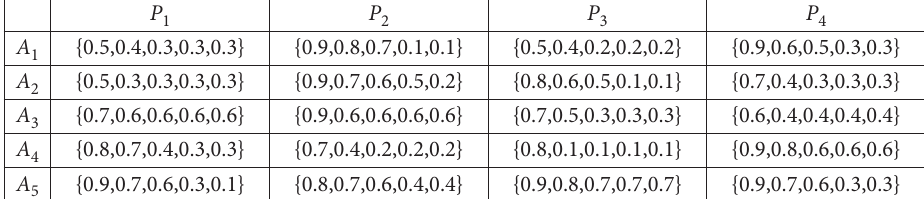
Table 2. Hesitant fuzzy decision matrix